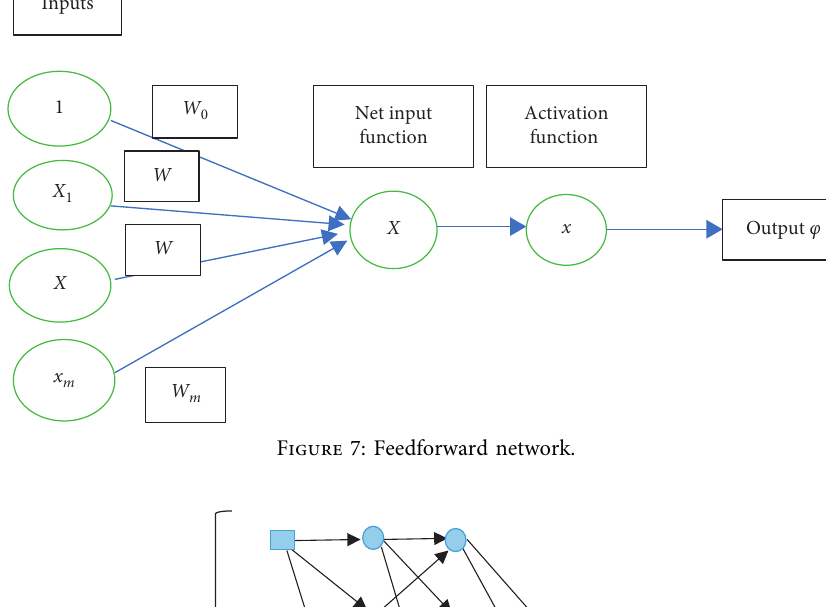
Figure 7: Feedforward network.